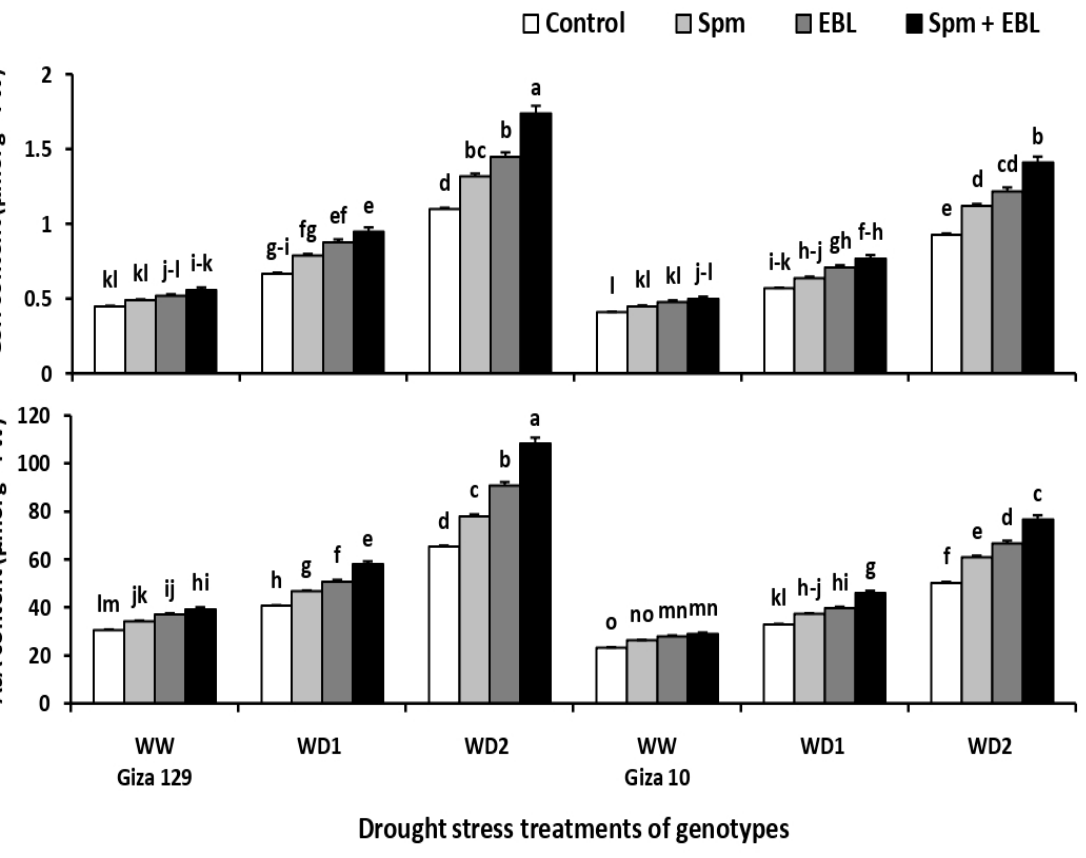
Figure 5. Influence of foliar application with distilled water (control), 25 mg L − 1 Spm, 0.1 mg L − 1 EBL, or 25 mg L − 1 Spm + 0.1 mg L − 1 EBL on the content of reduced glutathione (GSH) and ascorbate (AsA) in leaves of maize plants of both genotypes—Giza 129 and Giza 10—exposed to drought stress treatments (control (100% field capacity (FC); WW) and water deficit (75% FC and 50% FC; WD1 and WD2)). Values are the mean ±SE (n = 6). Different letters indicate significant differences at p < 0.05 level according to LSD test.